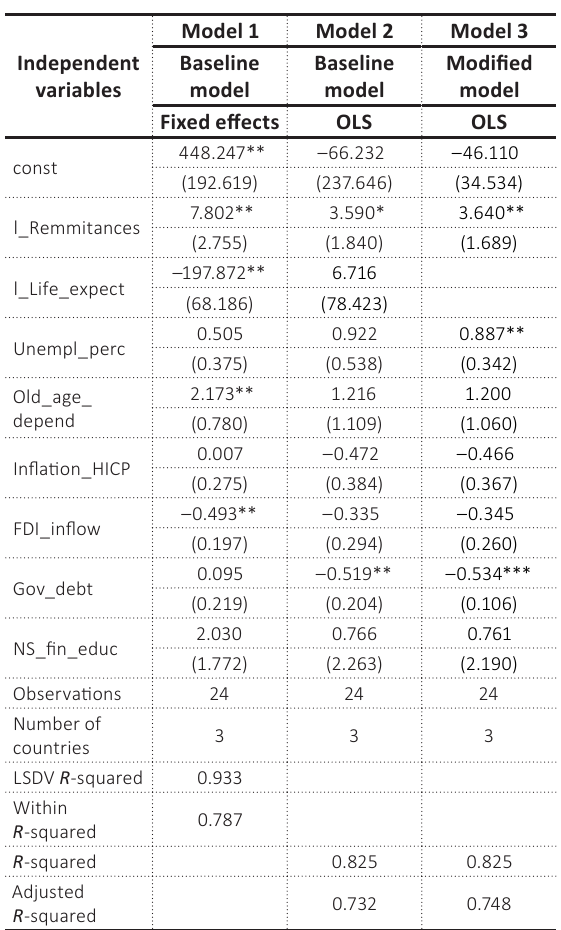
Table 3. Regression results